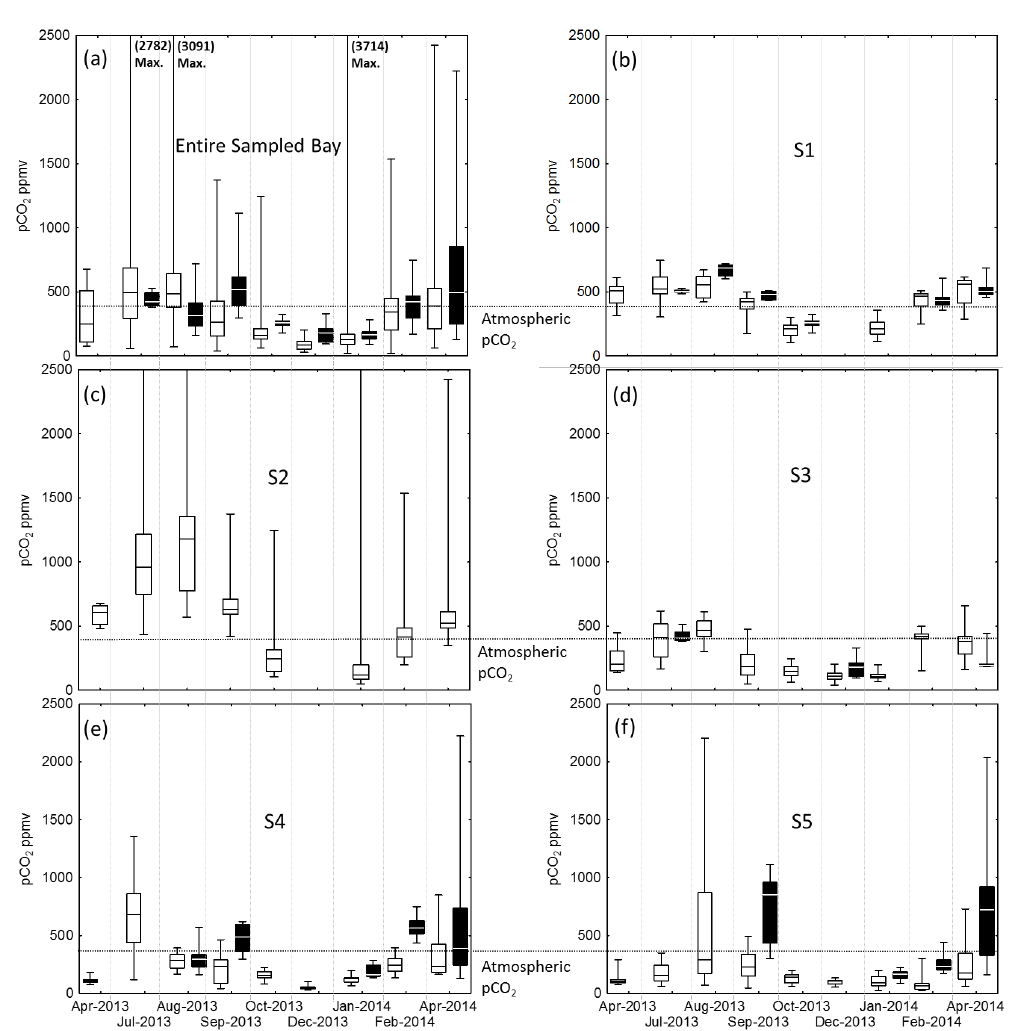
Figure 6. Box plots (maximum, 75th percentile, median, 25th percentile and minimum) of p CO 2 data for all the campaigns (a) and for each individual sector ( b , c , d , e and f ). Black box plots represents the night-time data ( < 09:30), when available, and white box plots represent daytime data ( >